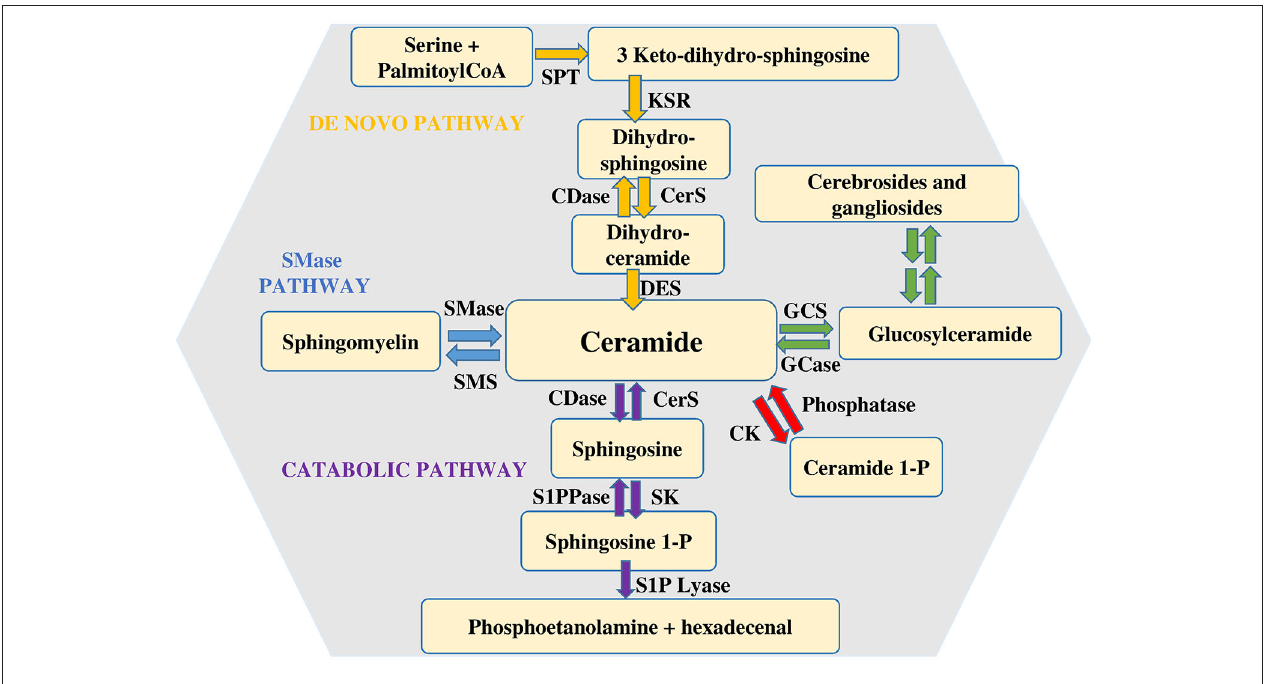
(dihydro)-ceramide synthase (CerS), ceramide desaturase (DES), ceramide kinase (CK), glucosylceramide synthase (GCS), glucosyl ceramidase (GCase), ceramidase (CDase), sphingosine-1-phosphate lyase (S1P lyase), sphingosine kinase (SK), sphingosine 1-phosphate phosphatase (S1PPase), sphingomyelin (SM) synthase (SMS), sphingomyelinase